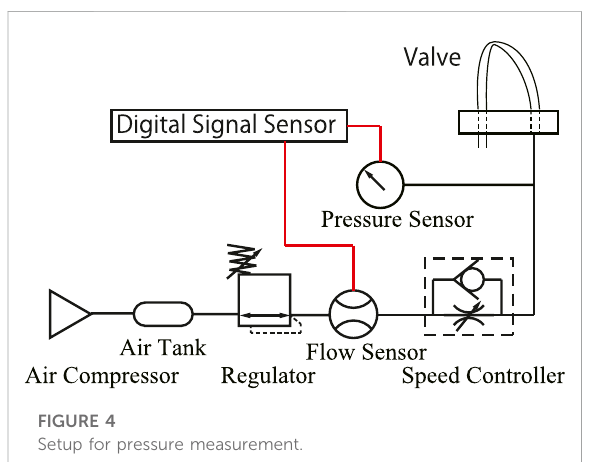
FIGURE 4 Setup for pressure measurement.